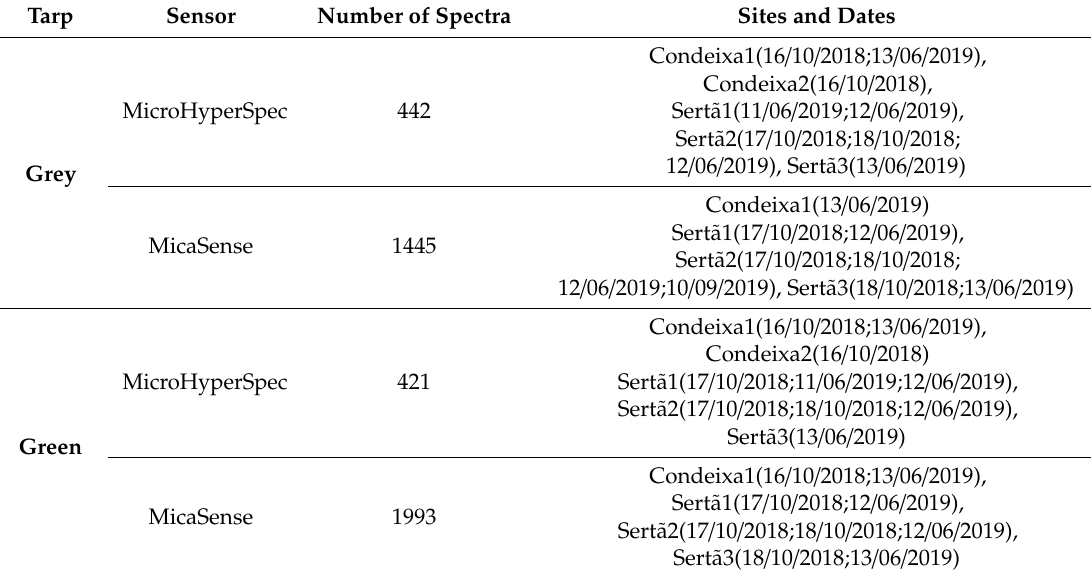
Table 3. Number of points extracted from the acquired imagery for the grey and green tarps. Tarp Sensor Number of Spectra Sites and Dates